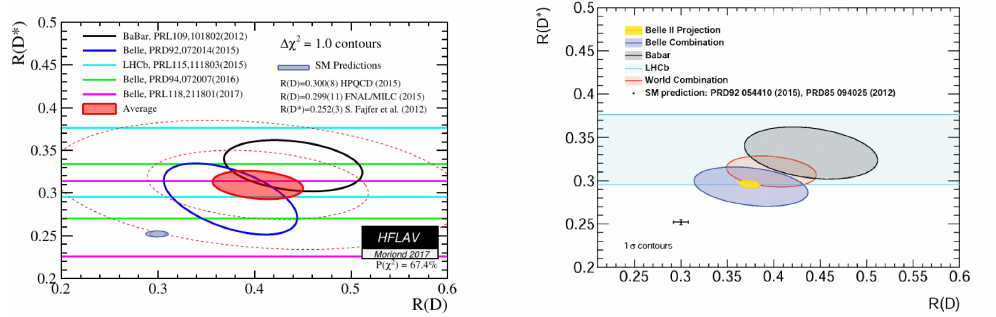
Figure 9. Measurement on R D and R D ∗ . The left plot shows the world average from [13]. The right plot shows the expected Belle II sensitivity with the 50 ab − 1